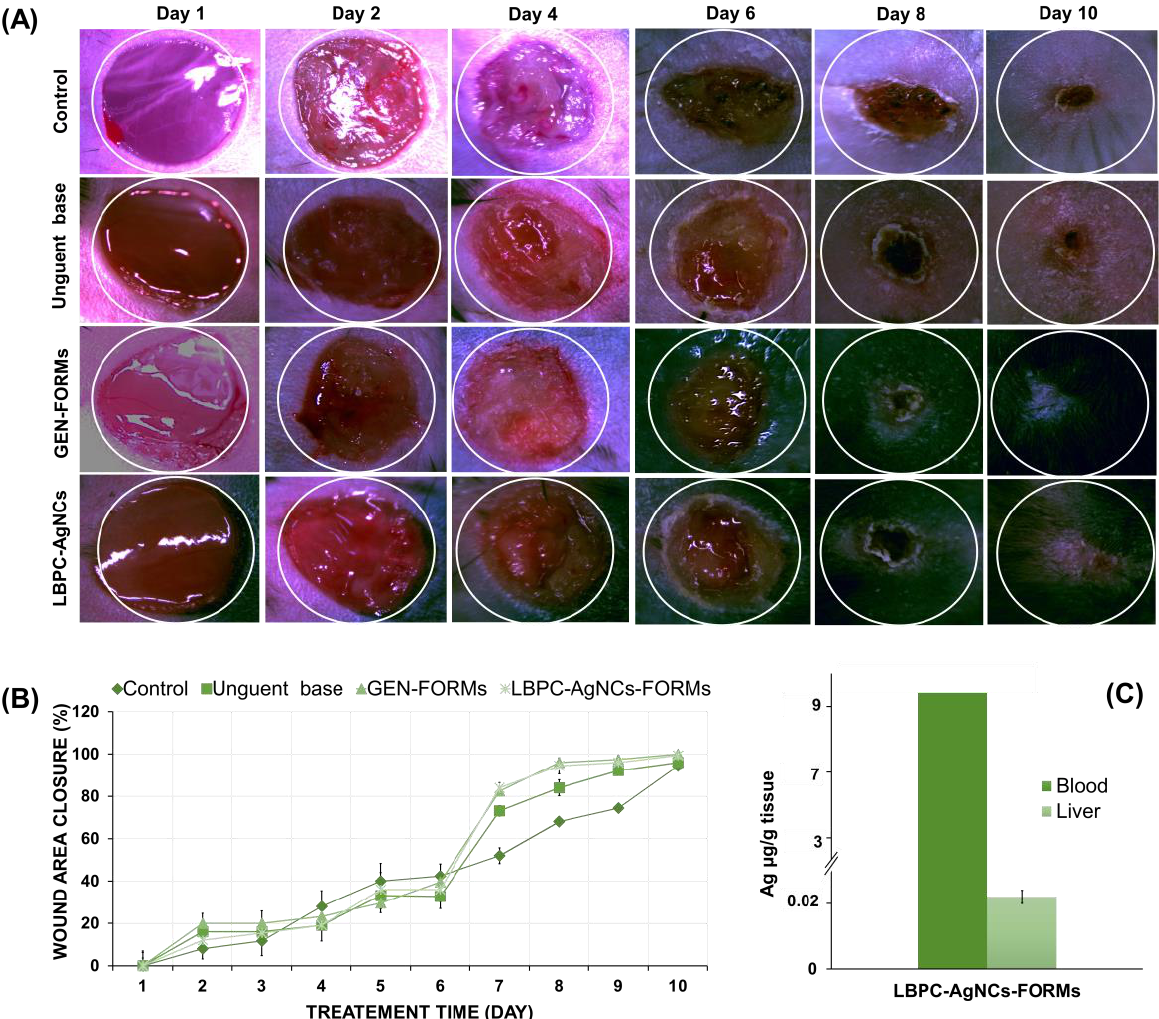
Figure 2. Illustration ( A ) and graphic representation ( B ) of the dynamic of wound-area closure, represented in %, based on three measurements during 10 day-monitoring and the Ag concentration in liver and blood samples ( C ).